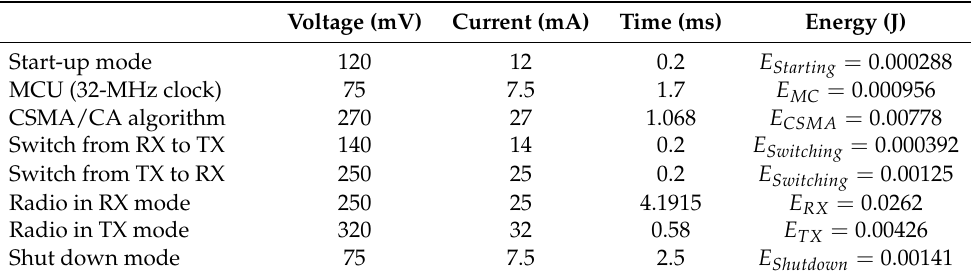
Table 3. Energy Model